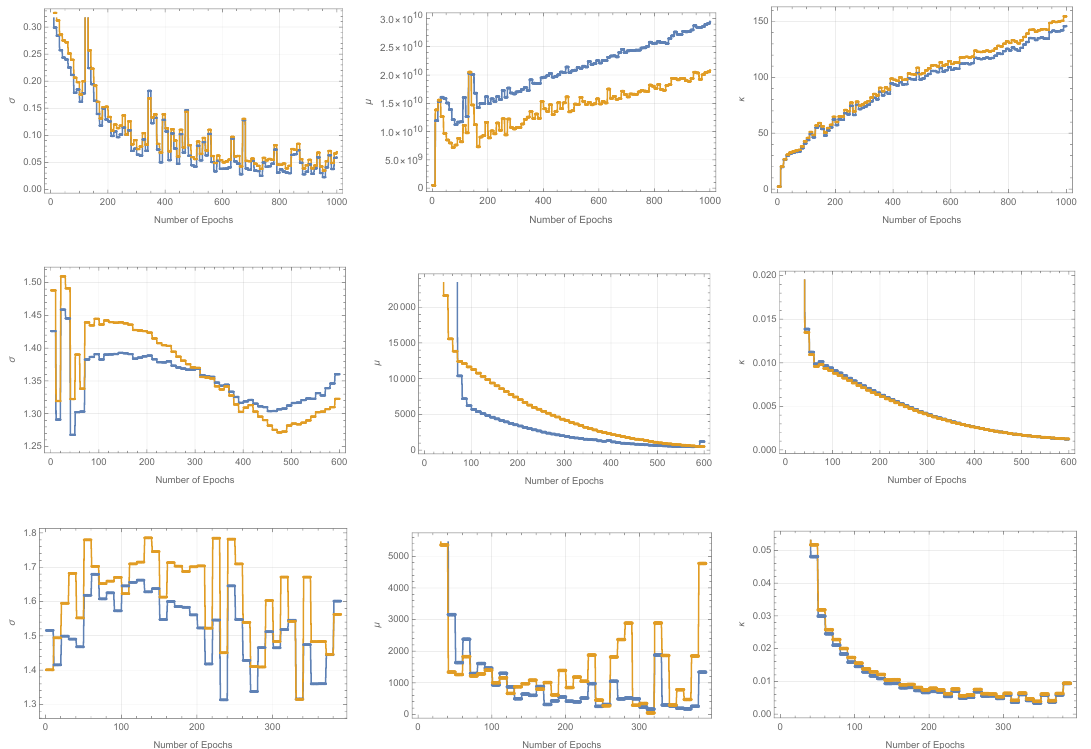
Figure 8 . Evolution of the various measures after training separately with different weights on the Fermat Quintic. In the first row only σ is taken as the loss function for training. We observe that as σ decreases in the training process both κ and µ increase. In the second and third rows we train using µ only and κ only. We observe that in both these cases µ and κ decrease simultaneously. The σ measure instead remains stable. In all the figures the blue lines correspond to the training set and yellow to the test